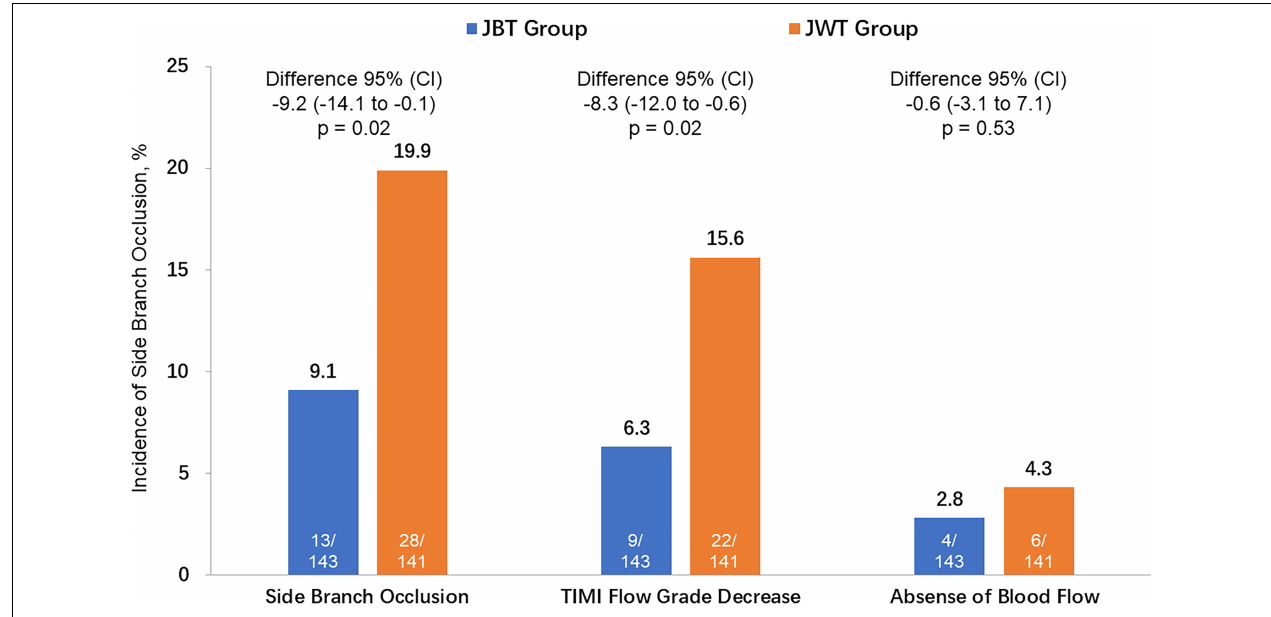
FIGURE 2 | The incidence of the primary endpoint [side branch (SB) occlusion] and its 2 components [TIMI (thrombolysis in myocardial infarction) flow grade decrease and absence of blood flow] between the SB protection jailed balloon technique (JBT) group and jailed wire technique (JWT) group. CI, confidence interval. TABLE 5 | Periprocedural myocardial infarction based on different definitions. Intention-to-treat population As-treated